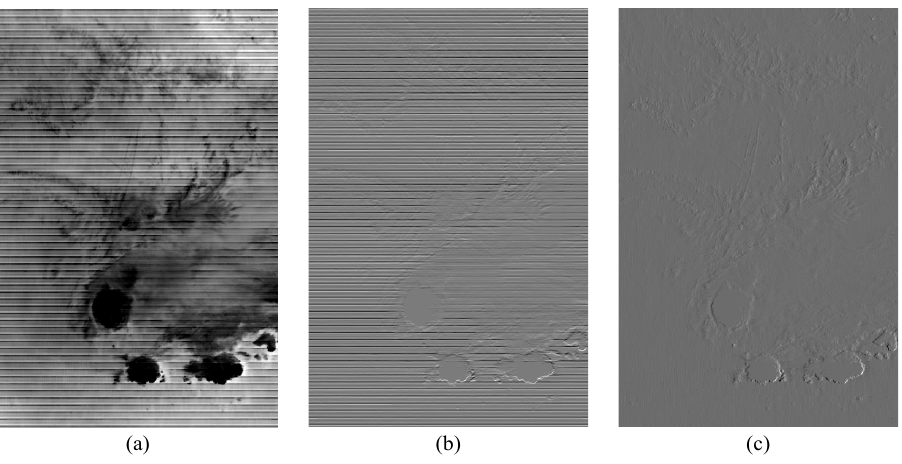
Figure 2. Gradient properties in MODIS data. ( a ) original stripe noise image; ( b ) gradient image vertical to the stripe; ( c ) gradient image along